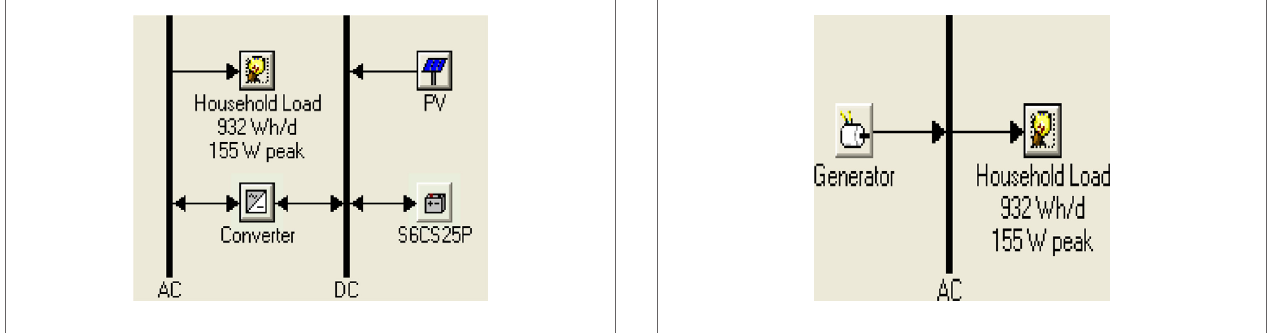
FigUre 6 | The network architecture for the hOMer simulator (650Va generator)